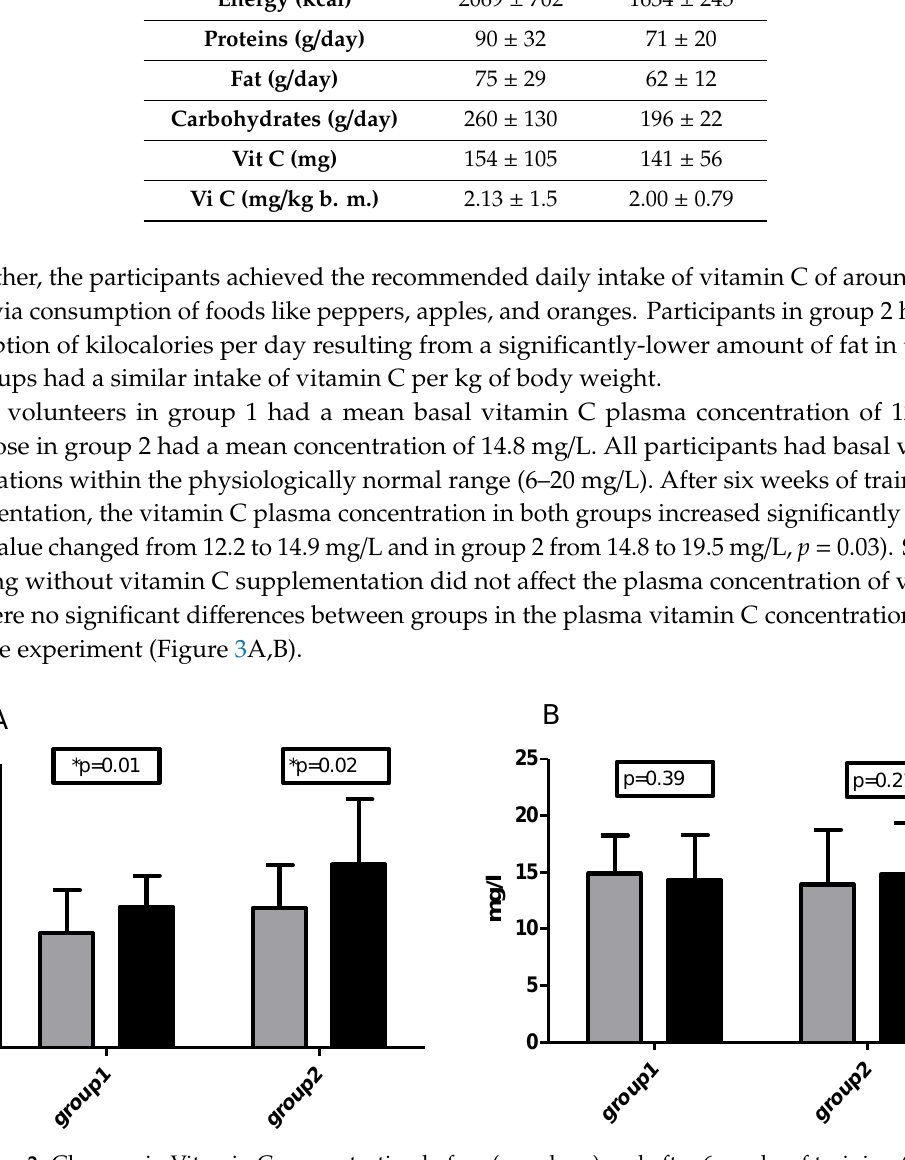
Figure 3. Changes in Vitamin C concentration before (grey bars) and after 6 weeks of training (dark bars). ( A ) Training period supported by supplementation and ( B ) unsupplemented training period. * significant differences compared to the baseline value ( p ˂ 0.05).